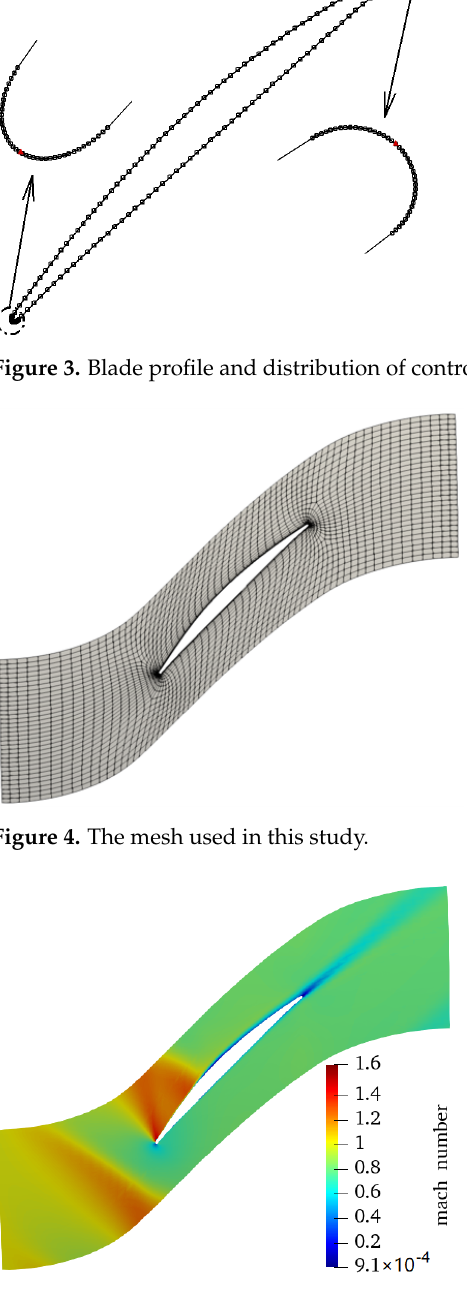
Figure 5. The relative Mach number distribution at the design